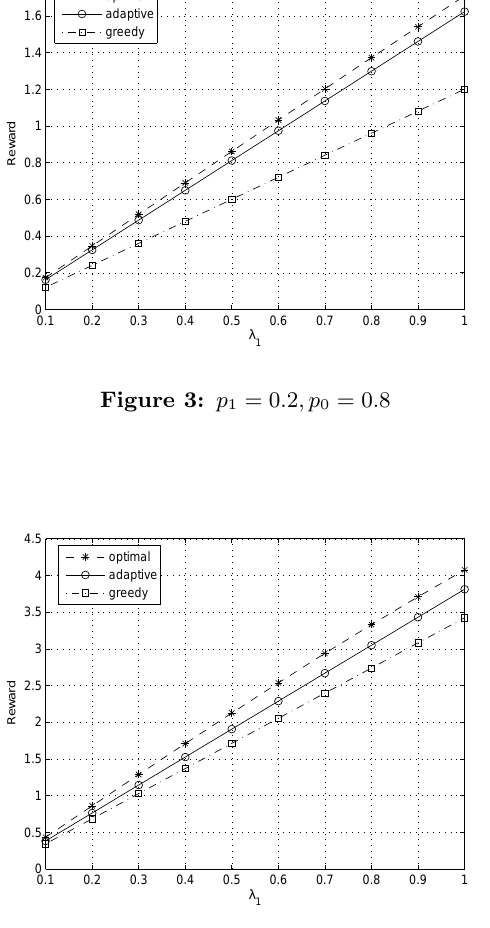
Figure 4: p 1 = 0 : 5 ; p 0 = 0 : 5